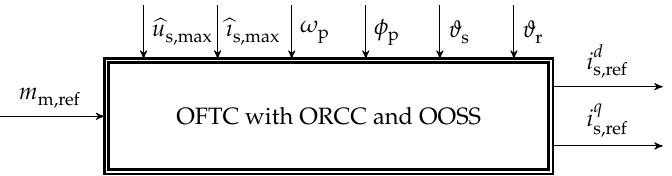
Figure 1. Optimal feedforward torque control (OFTC) with optimal reference current computation (ORCC) and optimal operation strategy selection (OOSS): The reference currents depend on desired (reference) torque, machine constraints, actual operating conditions and selected operation strategy (such as MTPL, FW, MC or MTPV).